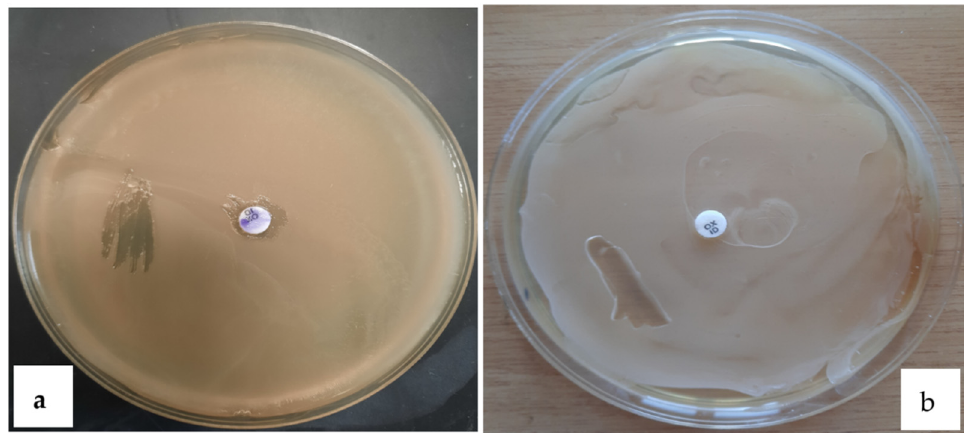
Figure 8. Sugar fermentation tests using lactose, maltose, fructose, galactose, dulcitol, and starch for ( a ) 1B and ( b ) 2D1 strains.